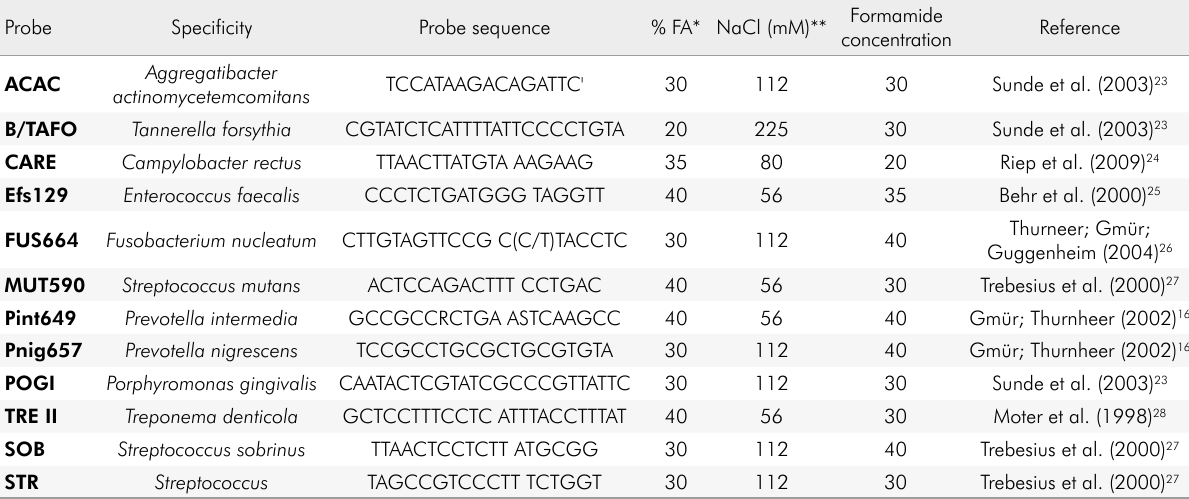
Table 1. Oligonucleotide probes of rRNA from microorganisms used in this study. All probes were labeled with Cy3